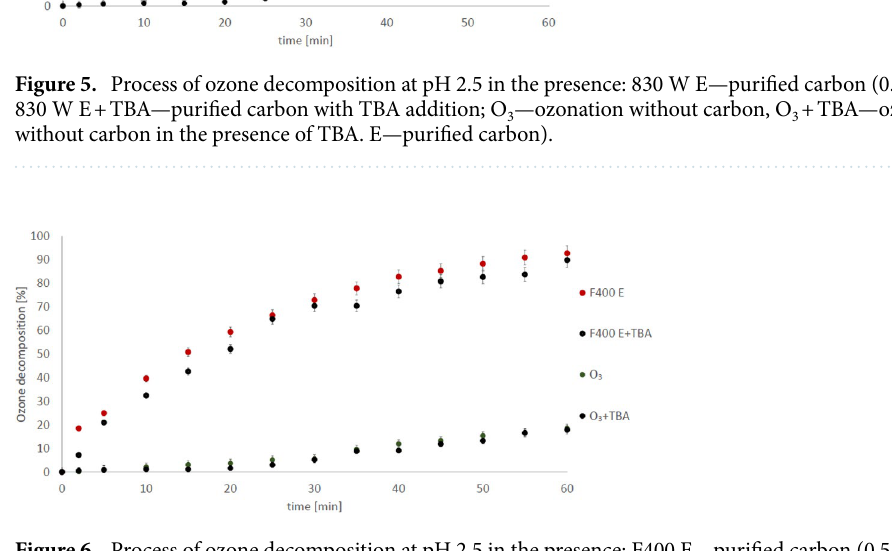
Figure 6. Process of ozone decomposition at pH 2.5 in the presence: F400 E—purified carbon (0.5 g/200 ml); F400 E + TBA—purified carbon with TBA addition; O 3 —ozonation without carbon, O 3 + TBA—ozonation without carbon in the presence of